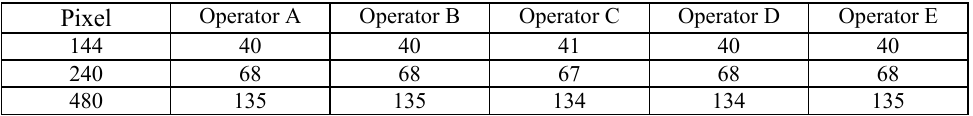
Table 5. Comparison of the measurement result by the operator in measurement of the same length when changing picture resolution Pixel Operator A Operator